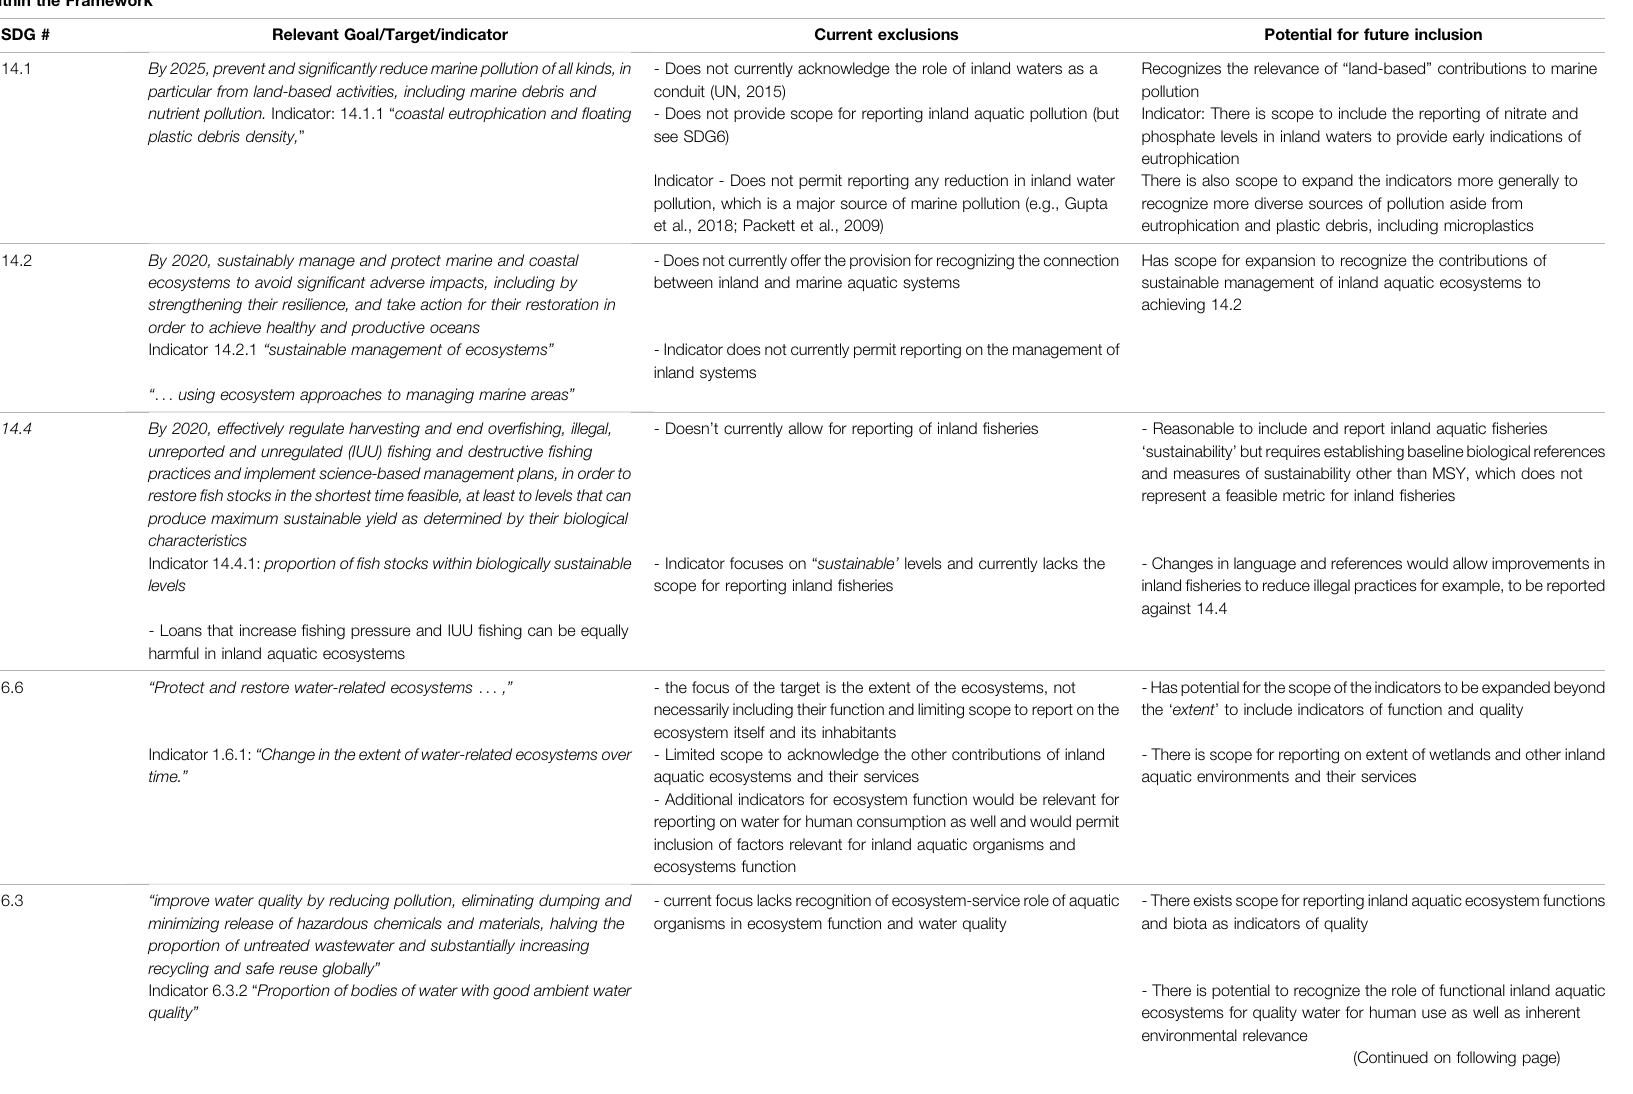
TABLE 1 | a) Existing SDG Targets and indicators with potential for reporting inland contributions, b) A Framework for supporting implementation and reporting of contributions from inland aquatic ecosystems and their services showing a theoretical set of objectives and c) providing universal indicators for inland fi sh, fi sheries and inland aquatic ecosystems that could be globally applicable and relevant to national circumstance. Table 1a Identi fi es Areas where, despite Current Limitations in the Indicators and Language of the SDGs, There is Potential for Future Inclusion and Reporting of Inland Aquatic Ecosystems, Inland Fish, and Fisheries within the Framework SDG # Relevant Goal/Target/indicator Current exclusions Potential for future inclusion